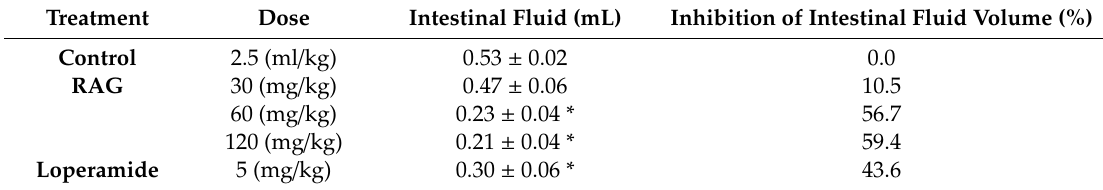
Table 3. E ff ect of red angico gum (RAG, 30–120 mg / kg, p.o.) on castor oil-induced intestinal fluid accumulation (enteropooling) in mice.